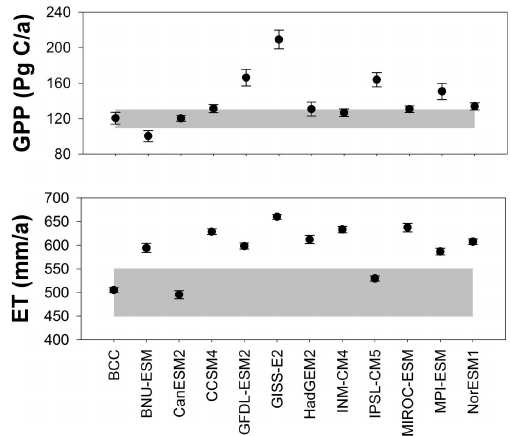
Figure 5. Mean annual gross primary production (PgCa − 1 ) and evapotranspiration (mma − 1 ) from the global land surface during 1901–2010, as simulated by 12 Earth system models in the IPCC Fifth Assessment Report. The grey lines represent upper and lower limits based on